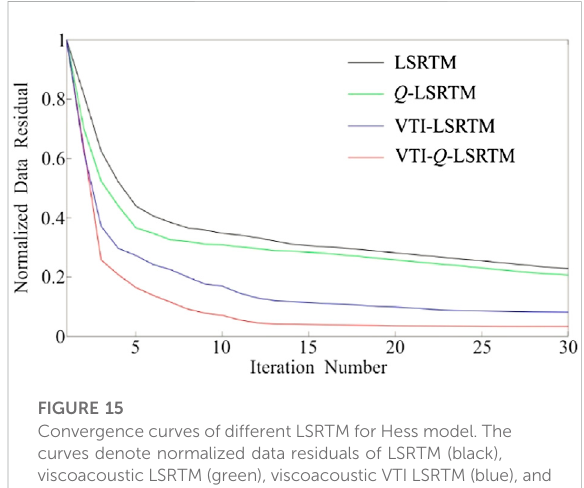
Convergence curves of different LSRTM for Hess model. The curves denote normalized data residuals of LSRTM (black),